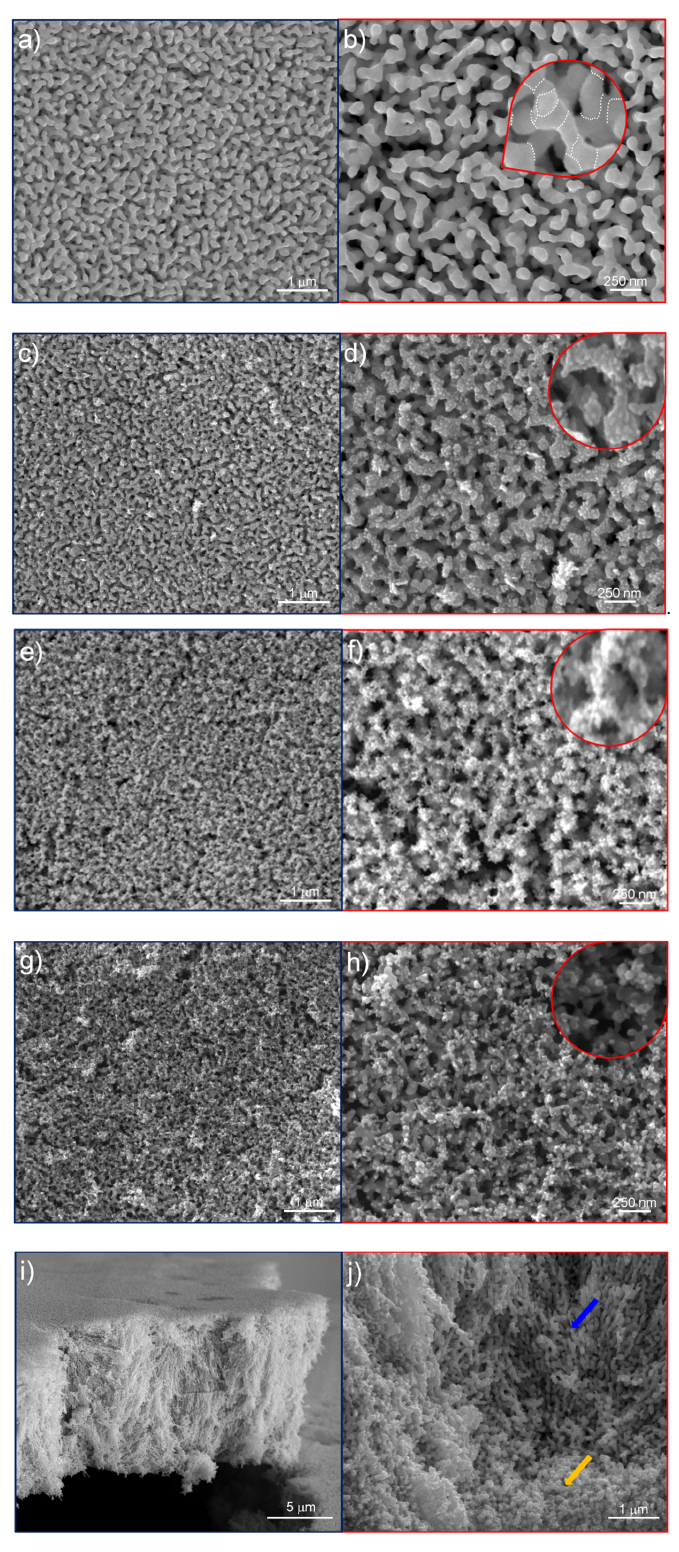
Figure 2. SEM images of the surface of samples: ( a , b ) NPG; ( c , d ) 3 min A ‐ NPG; ( e , f ) 5 min A ‐ NPG; ( g , h ) 7 min A ‐ NPG. In these insets, an increased level of detail of ligaments is shown; ( i ) cross ‐ sectional view of NPG; ( j ) cross ‐ sectional view of the 5 min A ‐ NPG. Anodization involved only a few microns on the nanoporous structure inside the thickness of the ribbon (yellow arrow); the inner part of the ribbon was indeed untouched by the treatment (blue arrow).